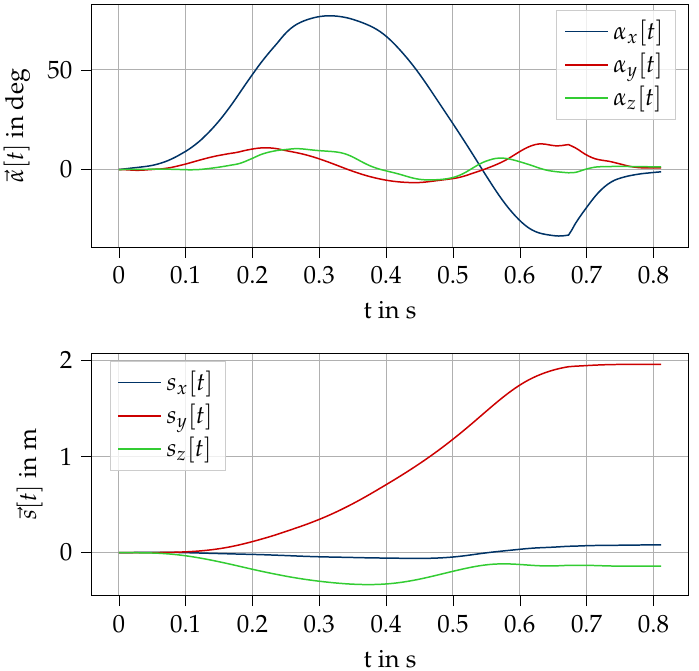
Figure A4. Visualization of the trajectory for a sample stride of the heel sensor. The upper plot shows the orientation (cid:126) α [ t ] obtained by the quaternion based forward integration after converting the quaternions back to their angle representation. The lower plot shows the translation (cid:126) s [ t ] obtained by dedrifted double integration of the gravity corrected acceleration (cid:126) a gc [ t